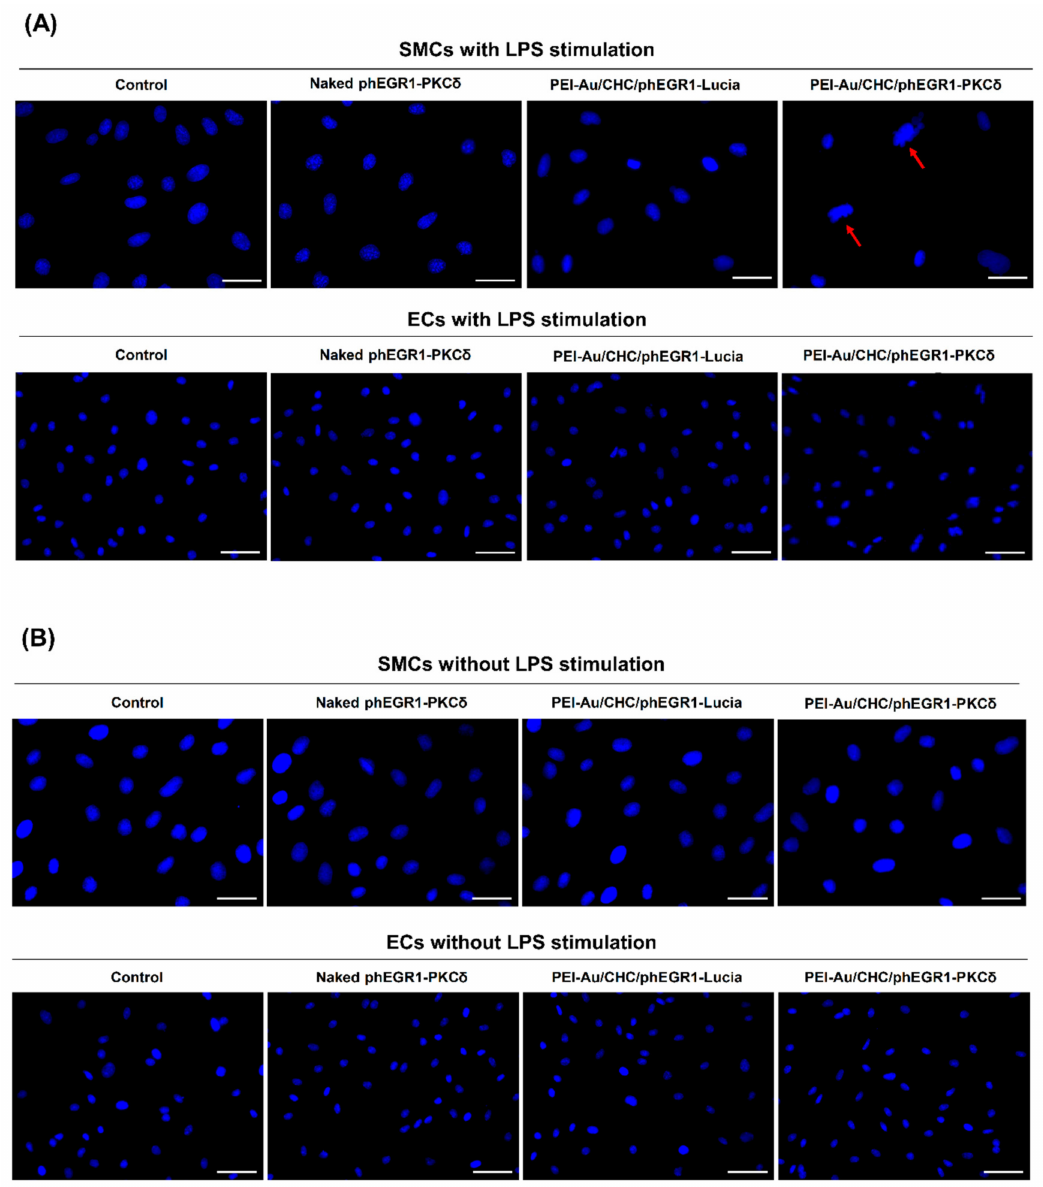
Figure 6. Nuclei morphology of ECs and SMCs treated with naked phEGR1-PKC δ , the PEI-Au / CHC / phEGR1-Lucia complex, and the PEI-Au / CHC / phEGR1-PKC δ complex ( A ) with LPS and ( B ) without LPS stimulation. All cells were stained with 4’,6-diamidino-2-phenylindole (DAPI) to label cell nucleus (blue). Arrow marks indicate apoptotic nuclei. Scale bar, 50 µ